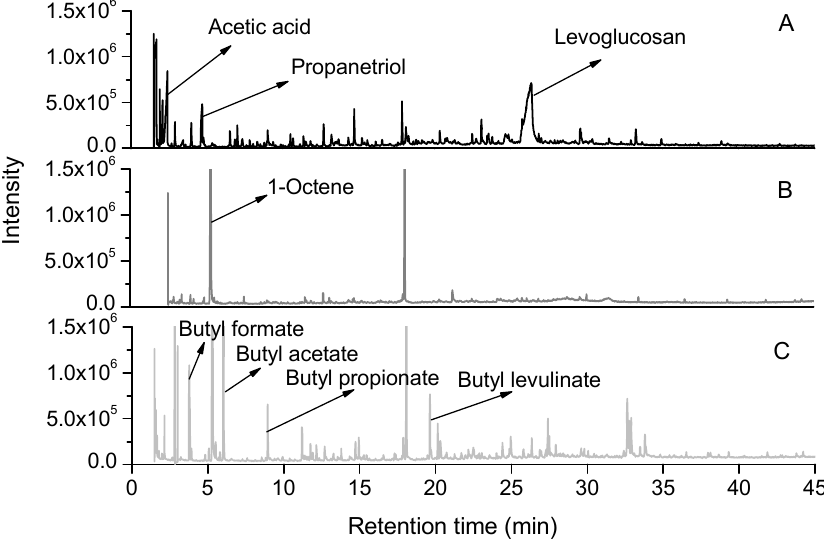
Figure 1. Gas chromatography-mass spectrometry (GC–MS) spectroscopy of ( A ) crude bio-oil; ( B ) bio-oil upgraded with neat 1-octene (weight ratio, raw bio-oil:1-octene = 1.5:0.6); and ( C ) bio-oil upgraded with 1-octene/1-butanol (weight ratio, raw bio-oil:1-octene l = 1.5:0.6:0.75) at 120 °C for 3 h over silica sulfuric acid (SSA).